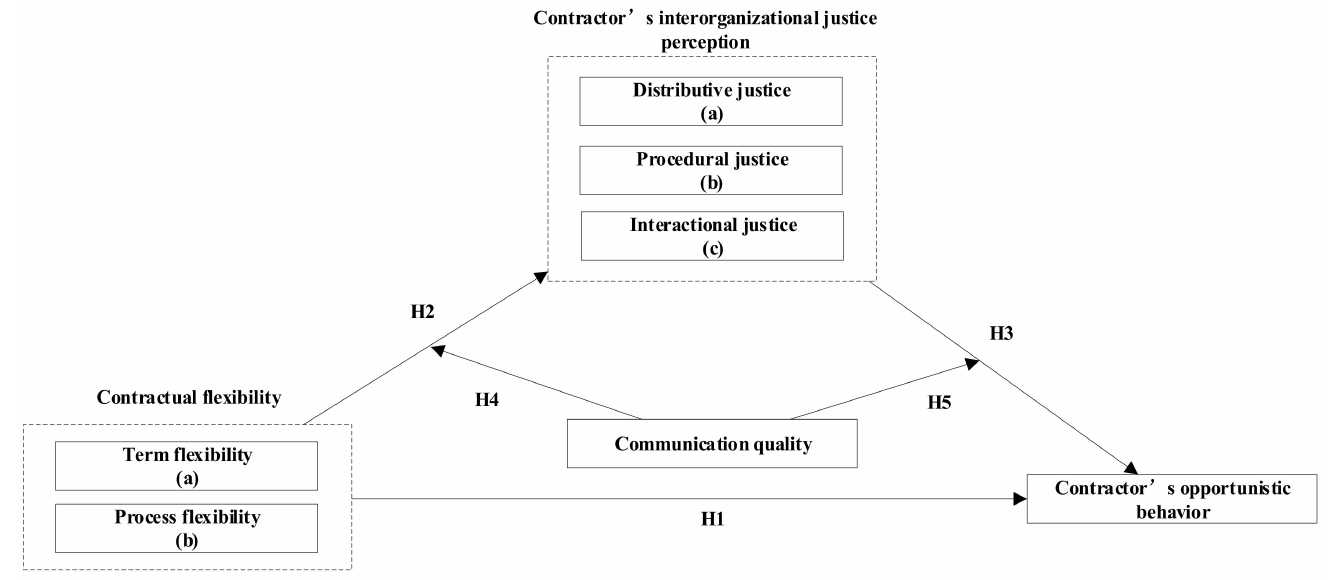
Figure 1. Theoretical